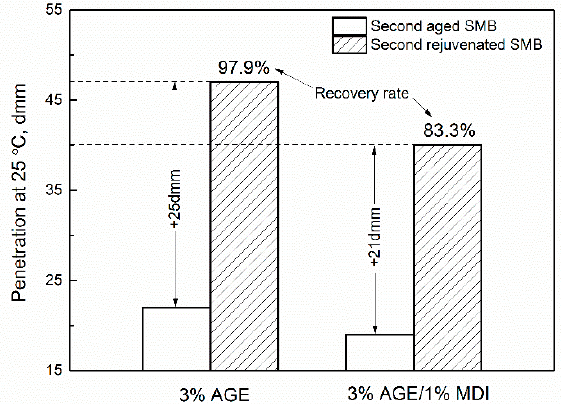
Figure 3. Effect of rejuvenating systems on the penetration of second-aged SMB.